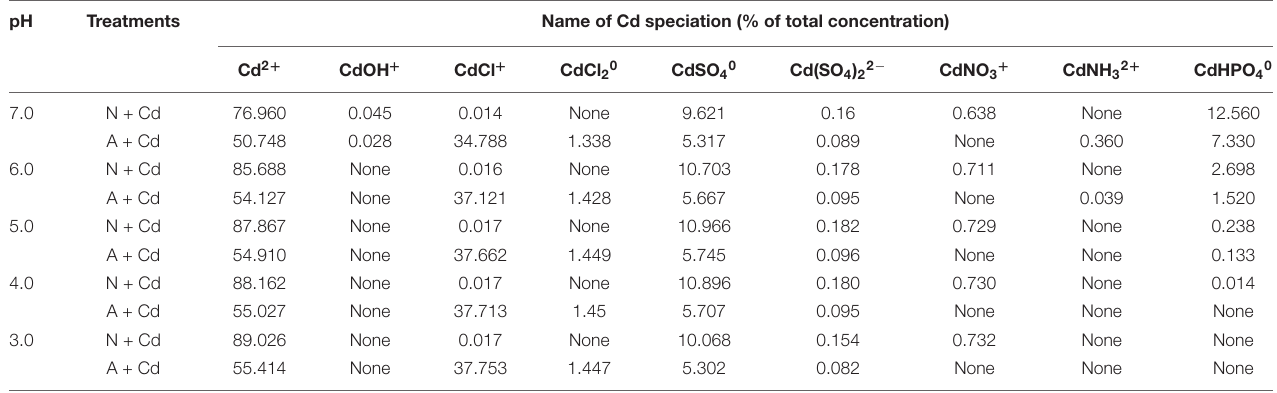
TABLE 1 | Distribution of Cd speciation as affected by nitrate and ammonium under different pH values in the growth medium. pH Treatments